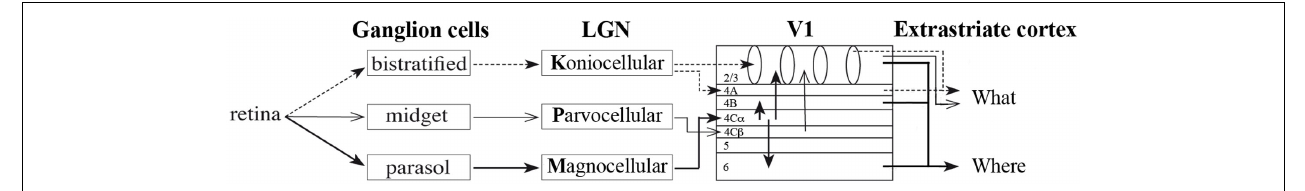
FIGURE 2 | Schematic representation of the structure of the visual hierarchy, organized in parallel pathways.